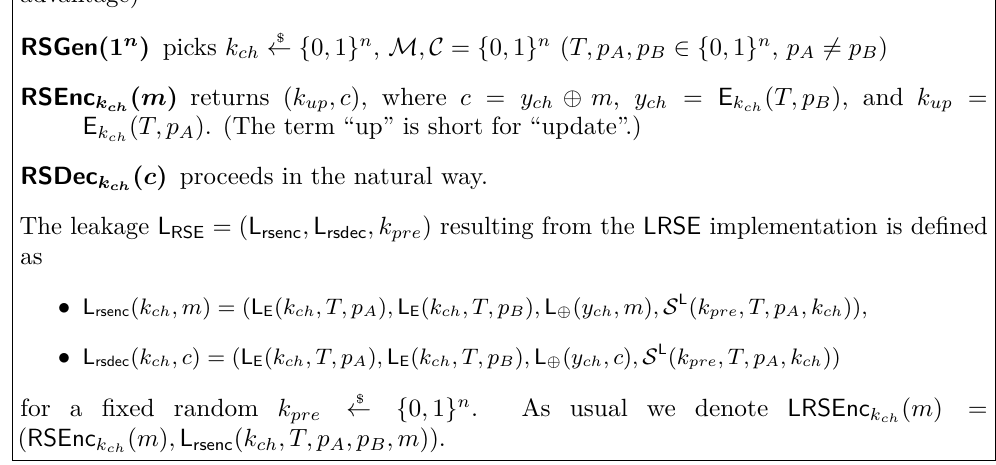
Figure 11: Basic unit: the single-block encryption scheme LRSE